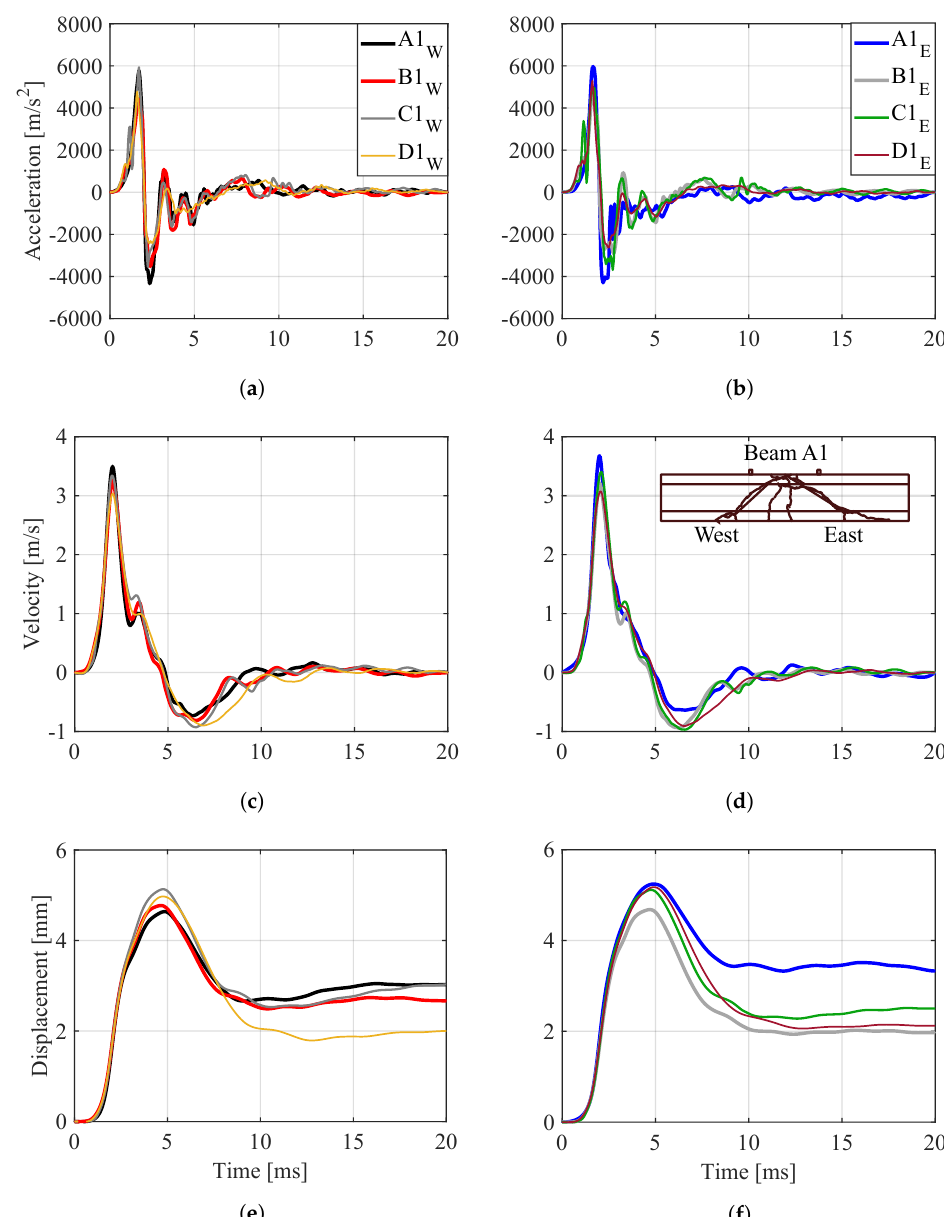
Figure 11. ( a ) Signal-processed acceleration at the west accelerometer for Beams A1–D1 during the first impact test; ( b ) acceleration at the east accelerometer for A1–D1 during the first impact test; ( c ) integrated velocity at the west accelerometer for A1–D1; ( d ) integrated velocity at the east accelerometer for A1–D1; ( e ) integrated displacement at the west accelerometer for A1–D1; and ( f ) integrated displacement at the east accelerometer for